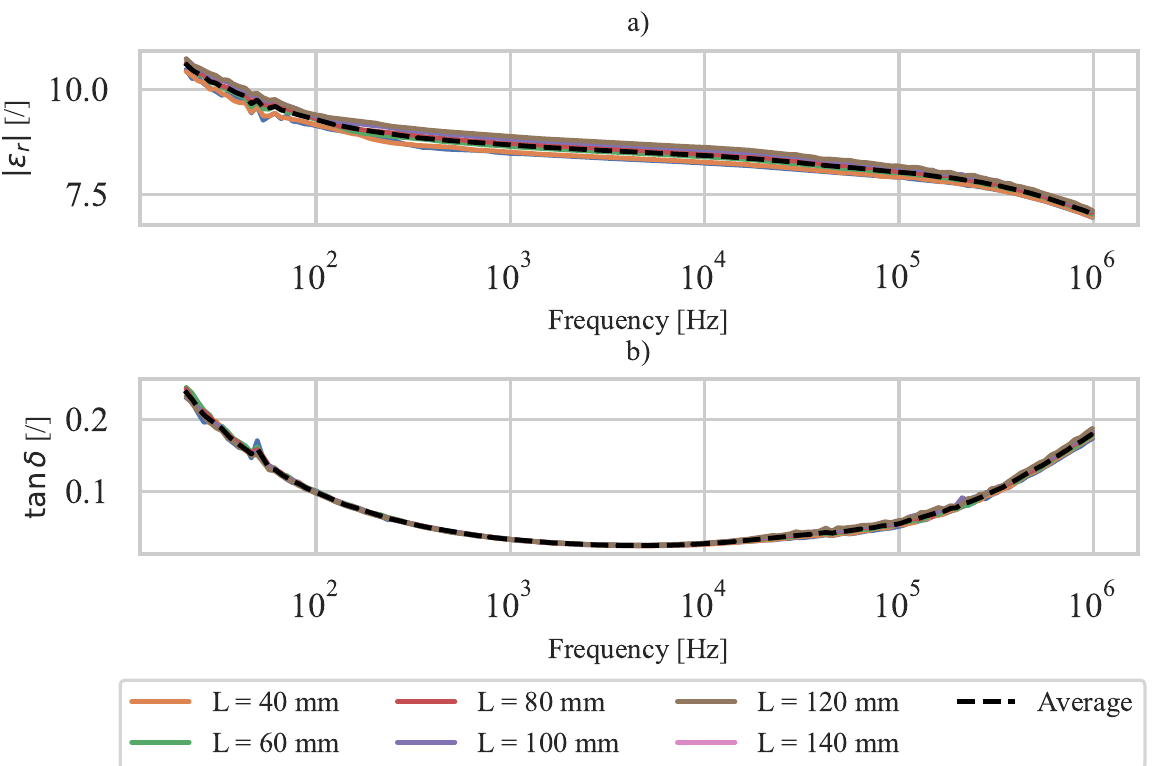
Figure 7. Measured dielectric constant ε r of PVDF: ( a ) absolute dielectric constant, ( b ) dielectric